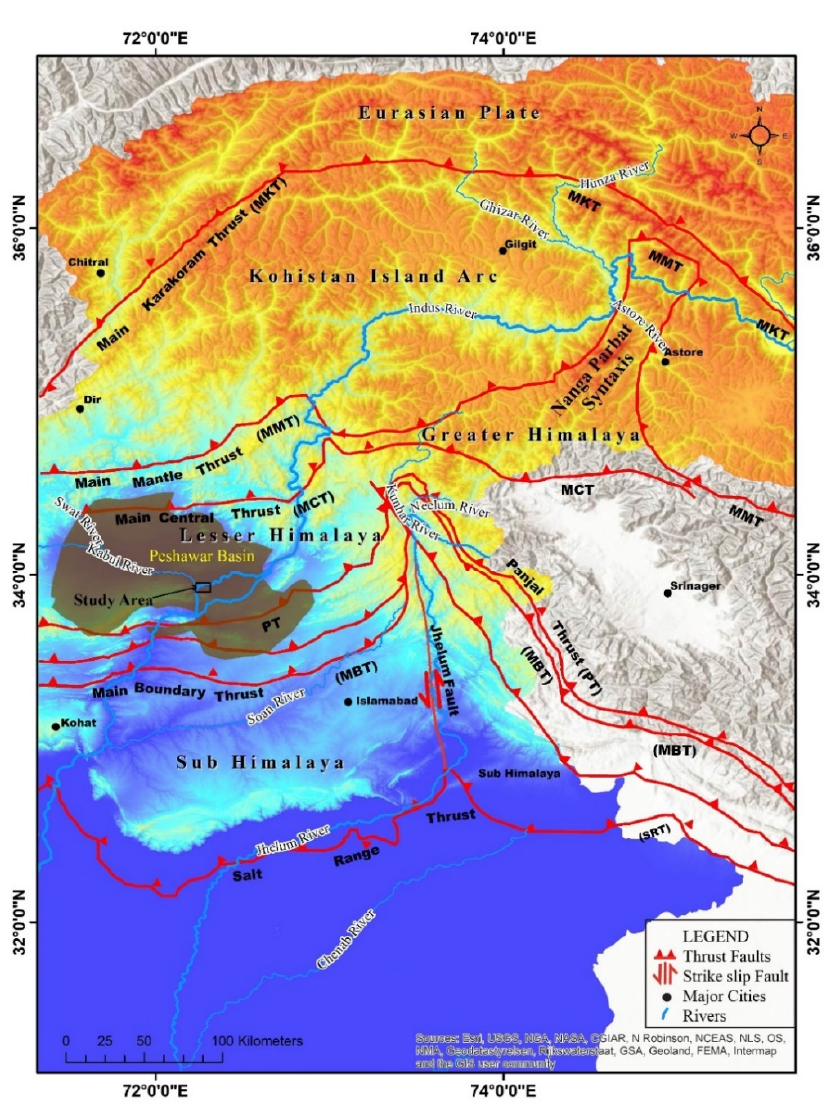
Figure 1. The regional tectonic map of Himalaya indicating the Peshawar basin and the major rivers flowing from the Himalaya to the study area, modified after [24,26,27].